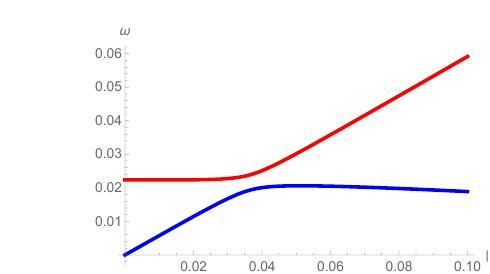
Figure 3 . Left: the k = 1 theory displays two gapless excitations with linear and quadratic disper- sion relation. Right: at (cid:12)nite large k , the two modes potentially cross, and also mix. The diagonal- ized modes display a splitting and \repulsion" resulting in a local maximum in the phonon branch. boson for the broken U(1) . At low momentum the leading such contribution scales as B p 4 (using eq. (A.3)). The new solutions to (3.14) provide a qualitative description of